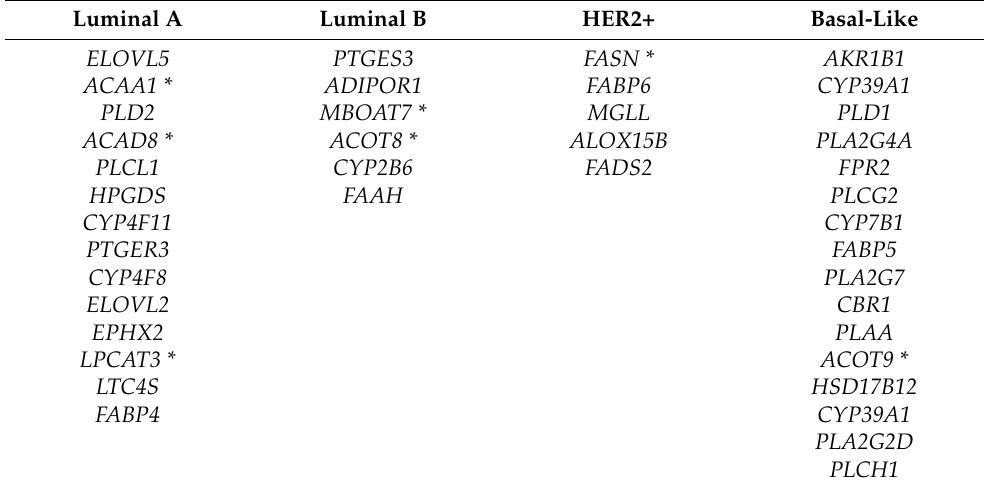
Table 1. Genes that are upregulated in the respective subtype.